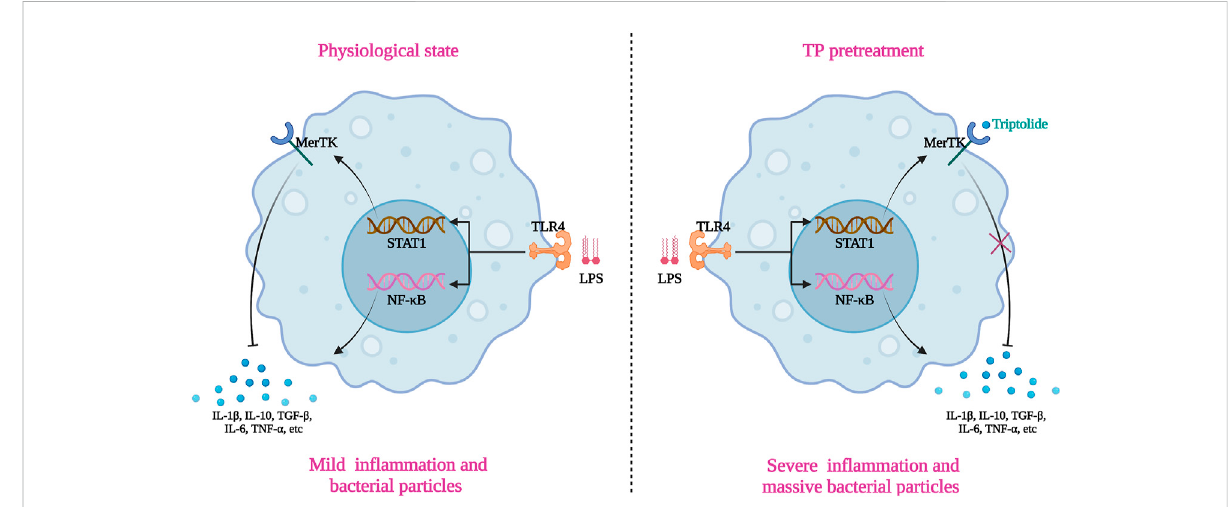
FIGURE 7 Schematic presentation indicated the suggested mechanisms by which macrophages malfunction in TP/LPS-induced indirect hepatotoxicity. The graphic was created with BioRender.com (aggrement number: